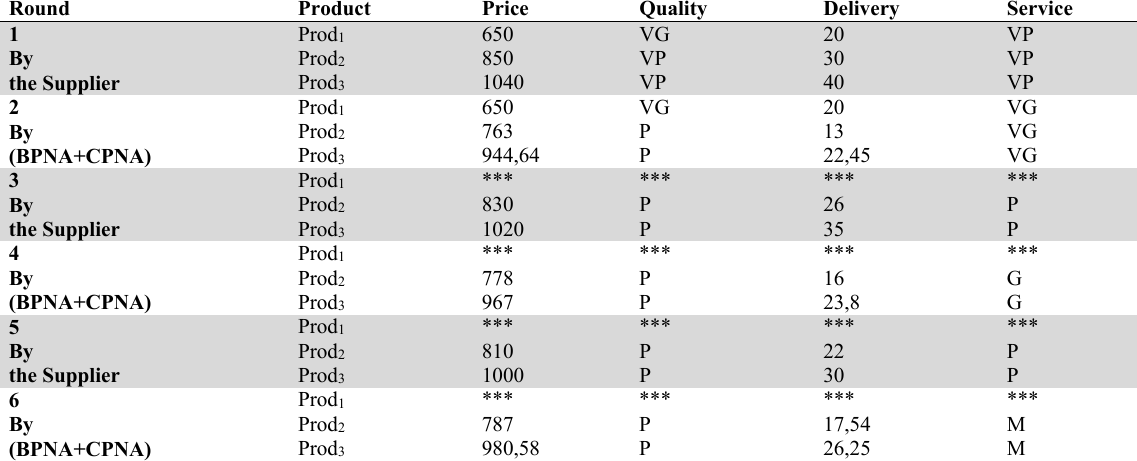
Results of protocol bargaining interactions